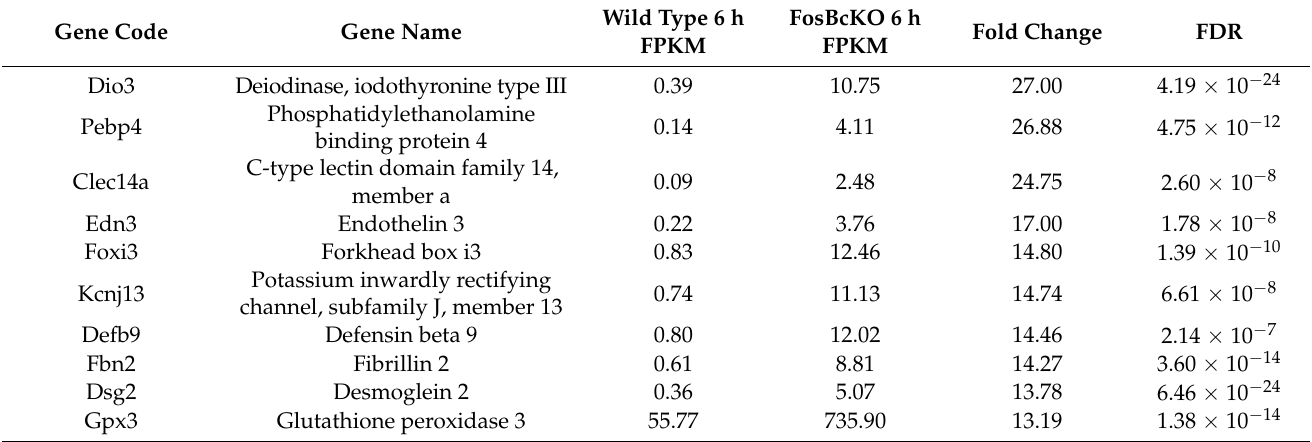
Figure 10. Fibrotic marker protein expression in FosBcKO LECs at 72 h PCS via immunofluorescence. ( A ) The fibrotic markers, Gremlin1 and Tenascin C (red) in wild type and and FosBcKO LECs at 72 h PCS. Blue = DNA, Scale bar = 70 µ m. ( B ) Quantitation of Tenascin C protein levels in LECs at 72 h PCS analyzed by immunofluorescence * p -value ≤ 0.05. ( C ) Quantitation of Gremlin1 protein levels in LECs at 72 h PCS analyzed by immunofluorescence p = 0.99. The black dots in B & C represent the individual biological replicates for each bar in the bar graph. Table 7. Top most upregulated DEGs in FosBcKO LECs at 6 h